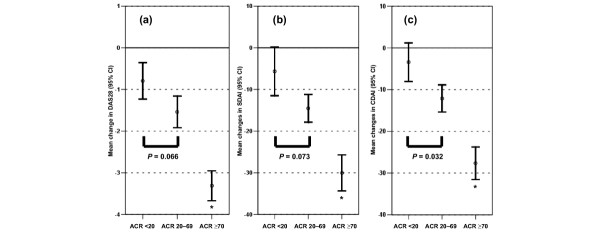
Changes in composite scores in relation to ACR response. Changes in (a) Disease Activity Score (DAS)28, (b) Simplified Disease Activity Index (SDAI) and (c) Clinical Disease Activity Index (CDAI) in relation to the achieved American College of Rheumatology (ACR) response of 91 patients in the inception cohort. ACR ranges were defined as ACR <20 (n = 28, 30.8%), ACR 20–69 (n = 20, 22.0%) and ACR ≥ 70 (n = 43, 47.2%), allowing analysis of independent observations. Error bars span the 95% confidence interval of the mean. Differences in group changes were statistically significant for all three scores (P < 0.0001, one-way analysis of variance). Presented P values for post hoc pairwise group comparisons are subjected to Bonferroni adjustment. *P < 0.0001 for ≥ ACR70 group compared with other groups.